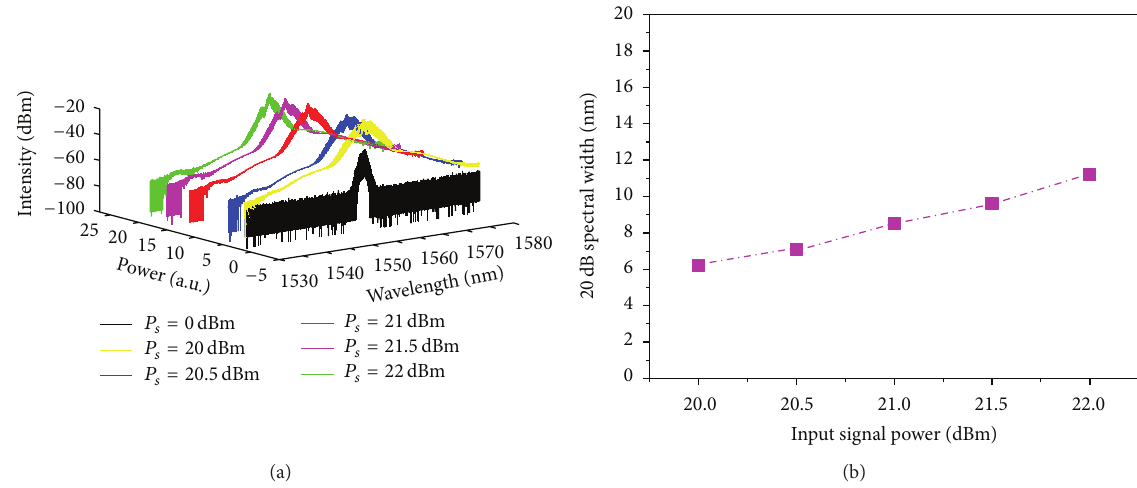
Figure 8: Eye diagrams of the filtered multicasting signals of channel 3 for (a) 𝜆 20 ps/div.